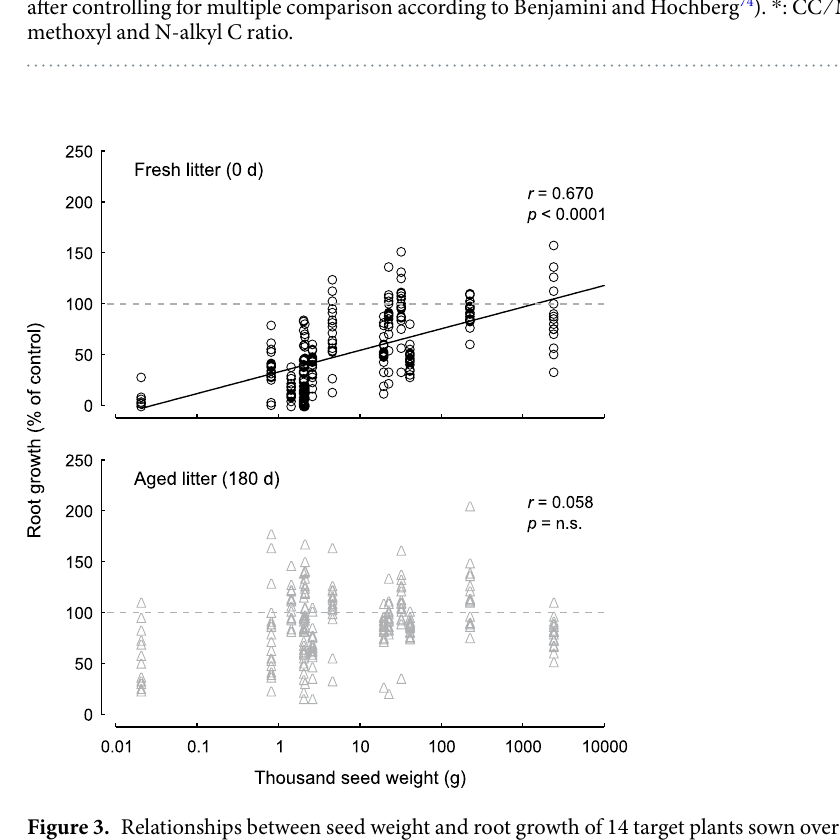
7 Scientific RePoRTS | 7: 9208 | DOI:10.1038/s41598-017-09145-w